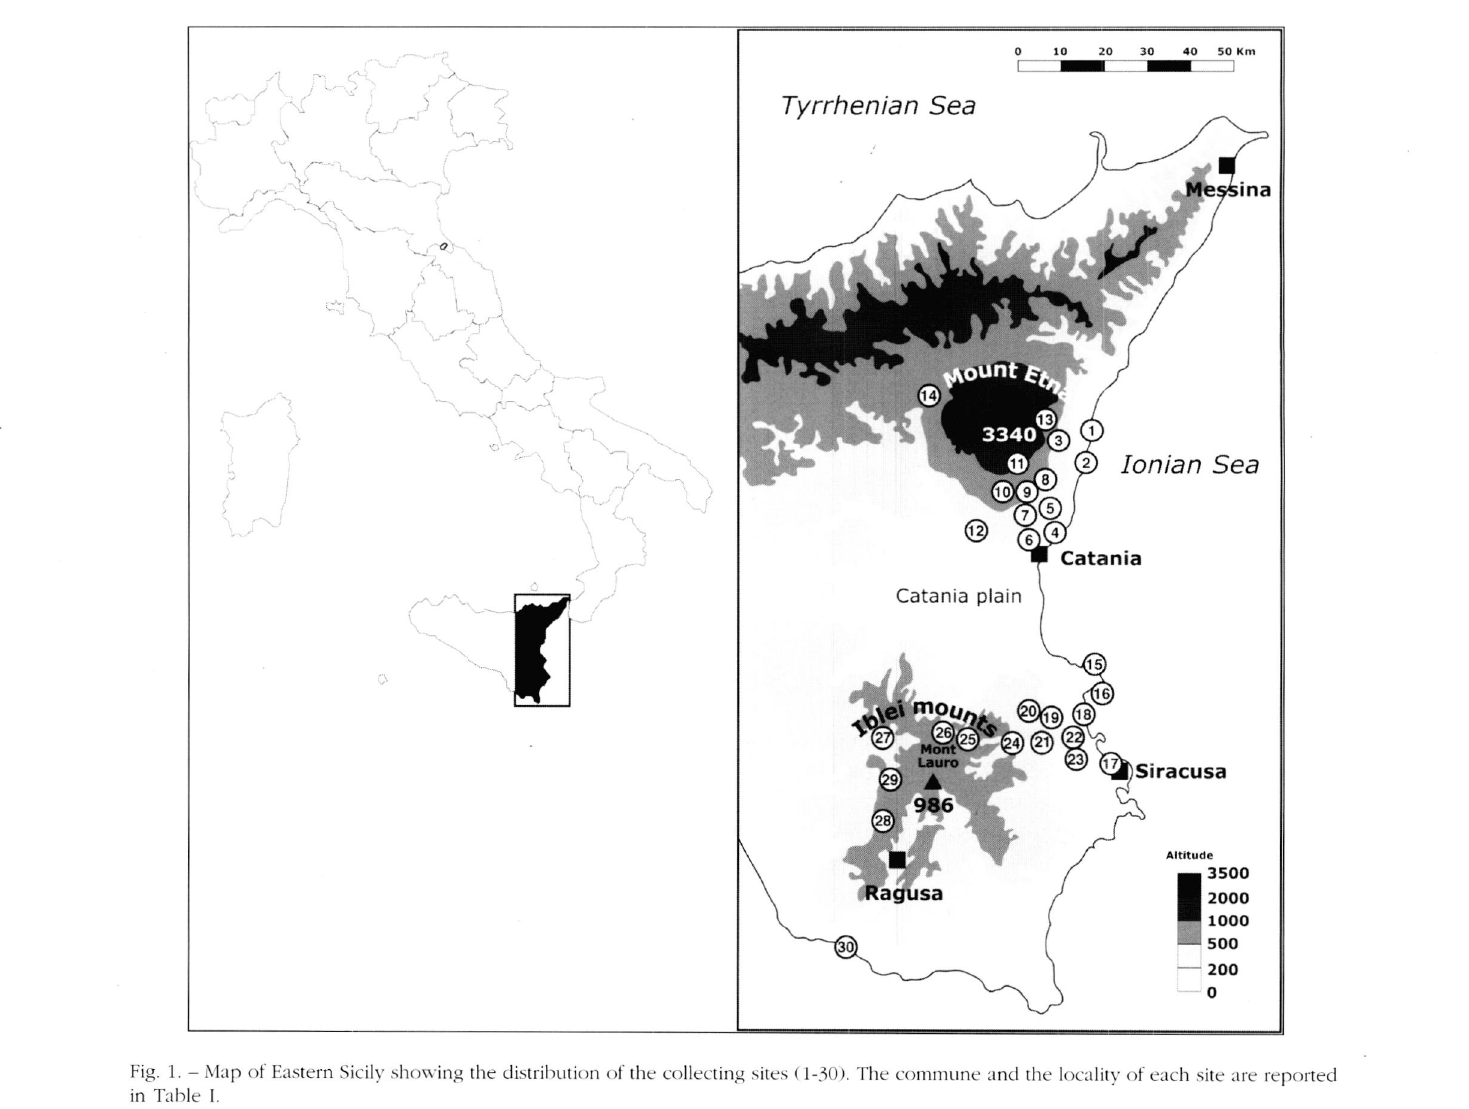
Fig. 1. - Map of Eastern Sicily .showing the distribution of the collecting sites ( 1-30). The commune and the locality of each site are reported in Table